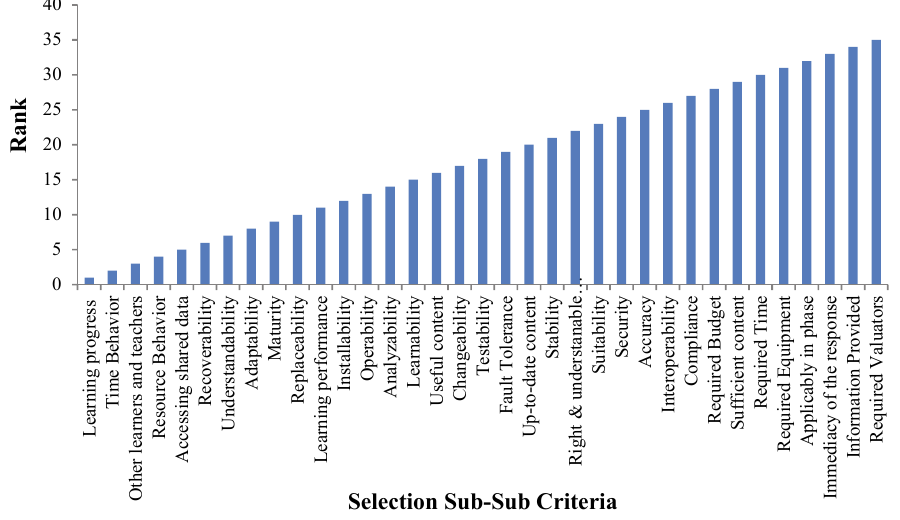
Fig. 3. Rankings of E-learning websites selection sub